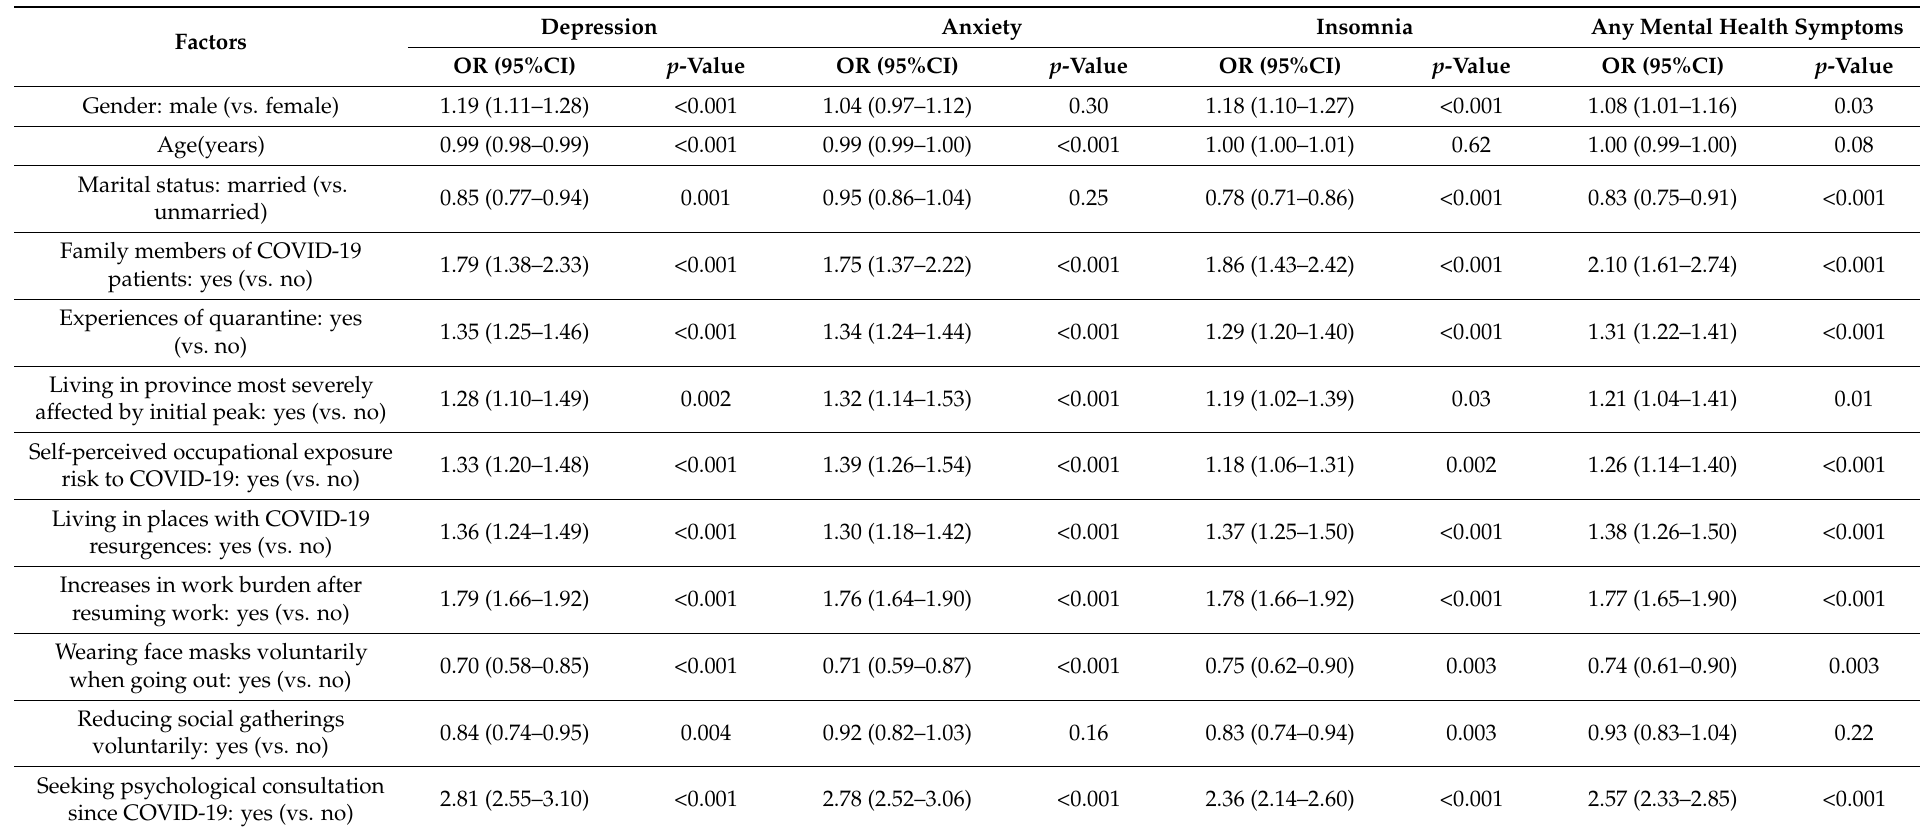
Table 4. Associated factors of positive of long-term depression, anxiety, insomnia and any mental health symptoms during the course of COVID-19 in the multivariable generalized estimating equation models a . Depression Anxiety Insomnia Any Mental Health Symptoms Factors OR (95%CI) p -Value OR (95%CI) p -Value OR (95%CI) p -Value p